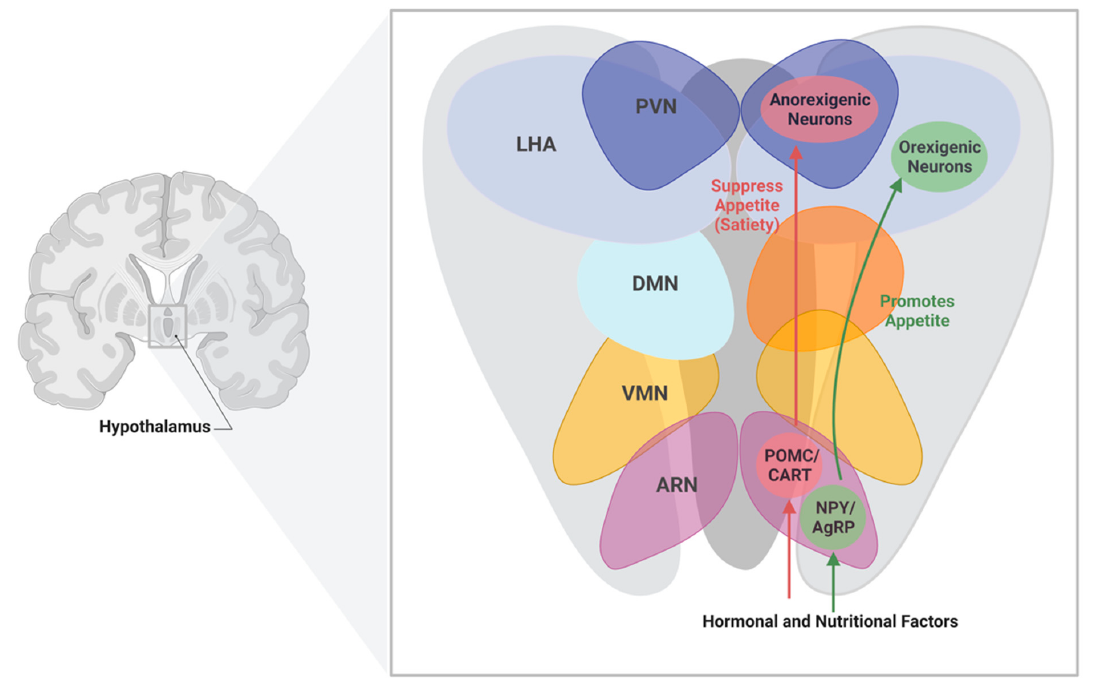
Figure 2. Hypothalamus nuclei associated with controlling energy homeostasis. Schematic repre- sentation of the frontal brain section indicating the location of the hypothalamus and the hypotha- lamic nuclei associated with energy homeostasis. Depending on the signals from the hormonal and nutritional factors, the neuronal connectivity can either suppress or promote appetite through POMC/CART or NPY/AgRP neurons in the ARN, respectively. Abbreviations: PVN: paraventricular nucleus; LHA: lateral hypothalamus area; DMN: dorsal medial nucleus; VMN: ventromedial nucleus; ARN: arcuate nucleus; POMC/CART: proopiomelanocortin/cocaine and amphetamine- regulated transcript; NYP/AgRP: neuropeptide Y/agouti-related protein. Created with BioRen- der.com. Table 2. Hypothalamus nuclei associated with controlling energy homeostasis [93].